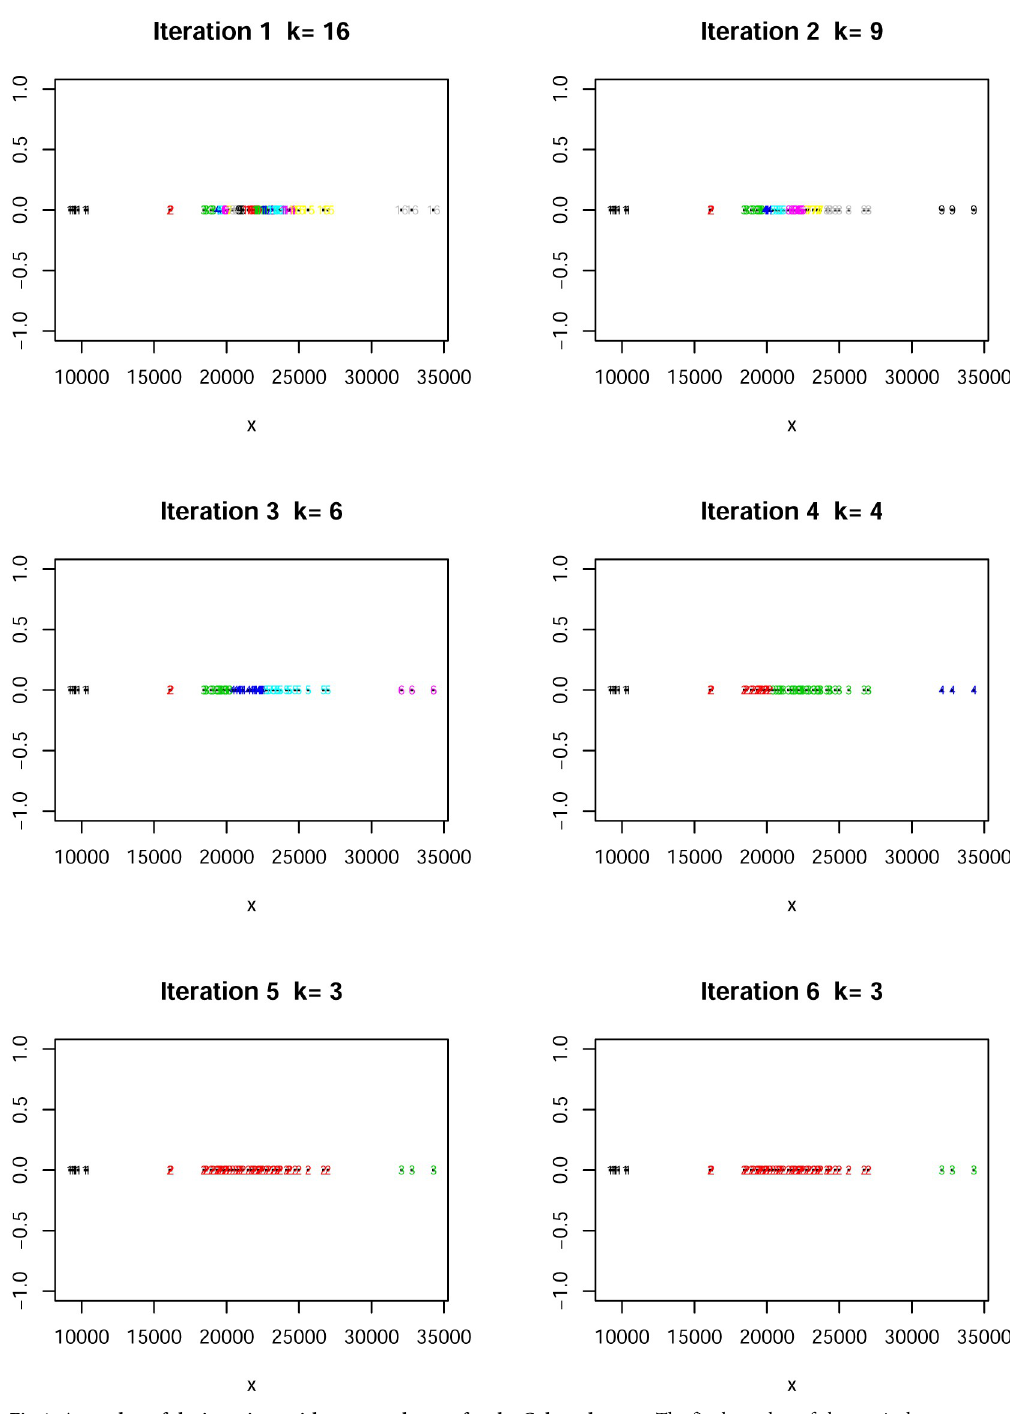
Fig 4. A number of the iterations with current clusters for the Galaxy data set. The final number of clusters is three.